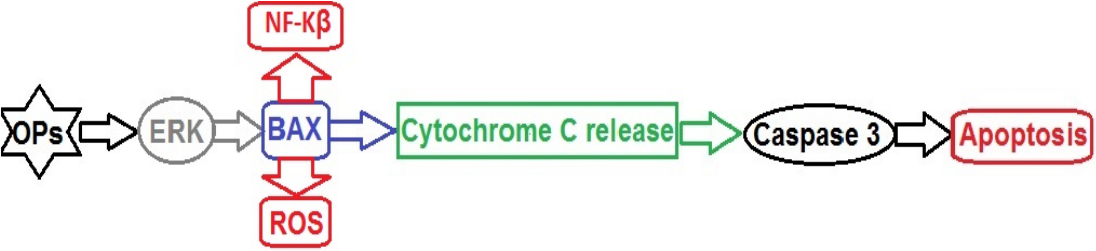
Figure 4. OP ‐ induced nephrotoxicity pathway mediated by MAPK signalling. Abbreviations: OPs: organophosphates, ERK: extracellular ‐ signal ‐ regulated protein kinase, NF ‐ K β : nuclear transcription factor kappa ‐β , ROS: reactive oxygen species.